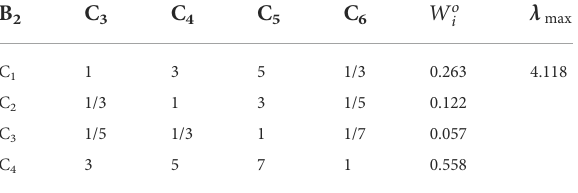
TABLE 4 Weights of second-tier indicators (1).